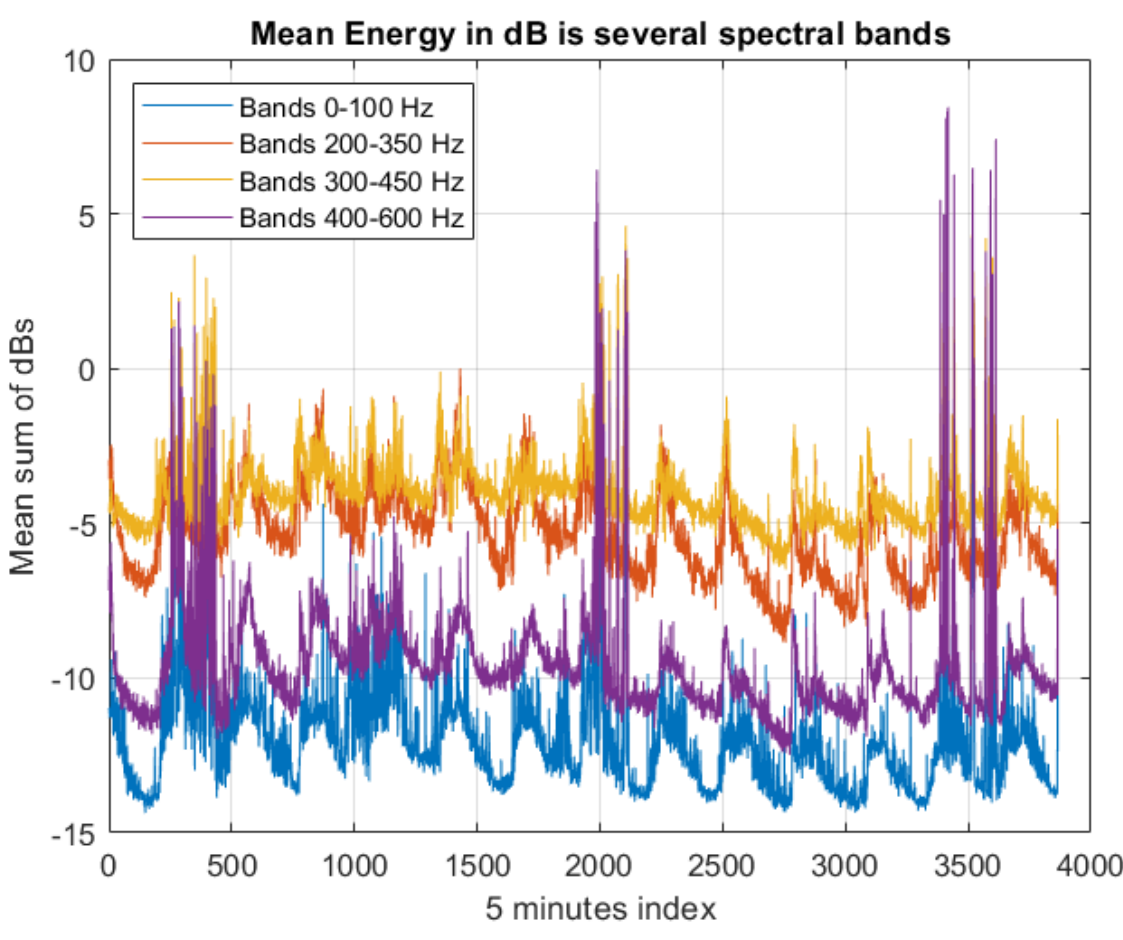
Figure 12. Descriptors of energy bands. The spectrogram is a time-frequency 2D representation in dB. The descriptors are summing the energy in the corresponding bands 0–100Hz, 200–350 Hz, 300–450 Hz, 400–600 Hz.